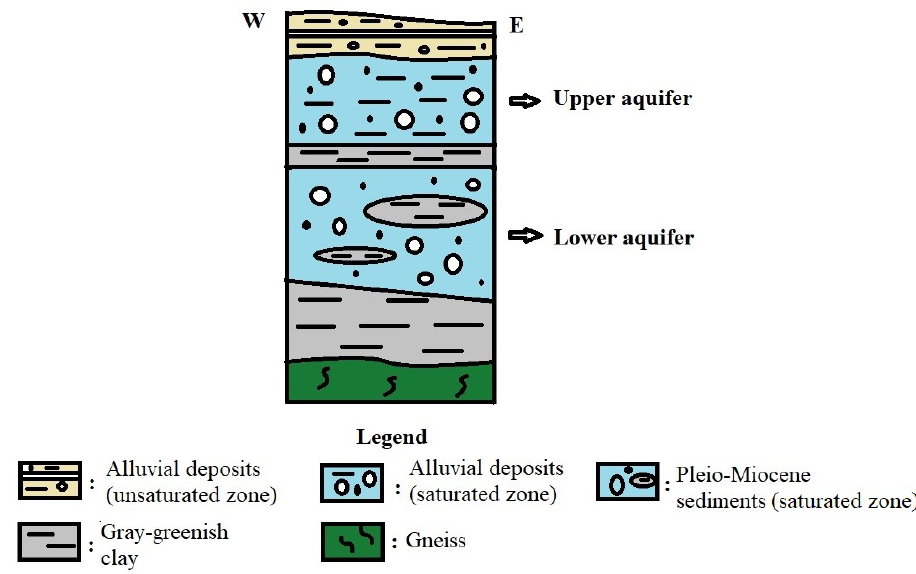
Figure 3. A geological cross-section (West-East) for the study area.